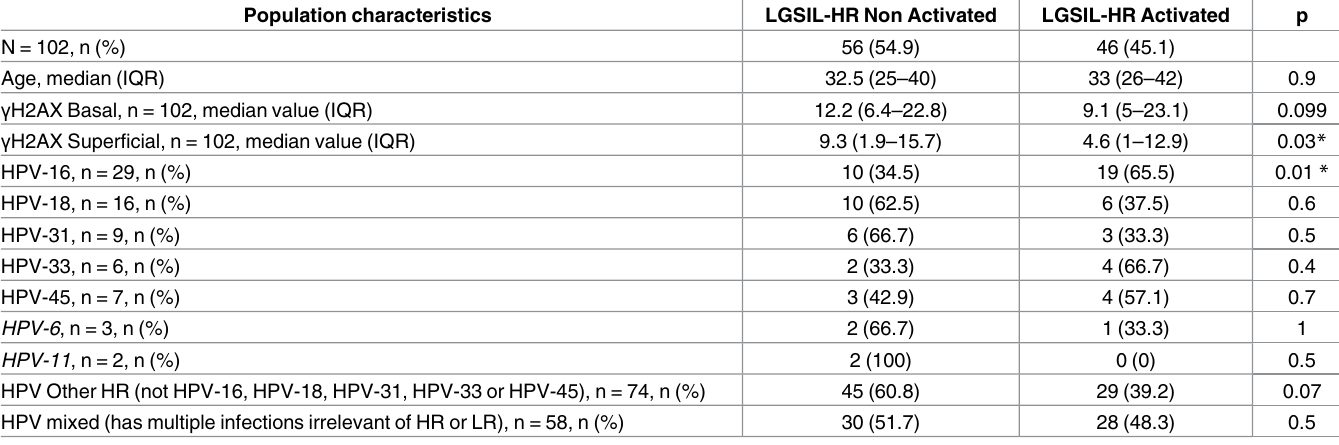
Table 3. Histologically confirmed low grade cases(LGSIL) where high risk (HR) HPV type infection (LGSIL-HR) was identified. Comparisonbetween activated (mRNA positive)and non-activated cases (mRNA negative)for 102 subjects. Statistically significantassociationare flaggedwith an asterisk. Population